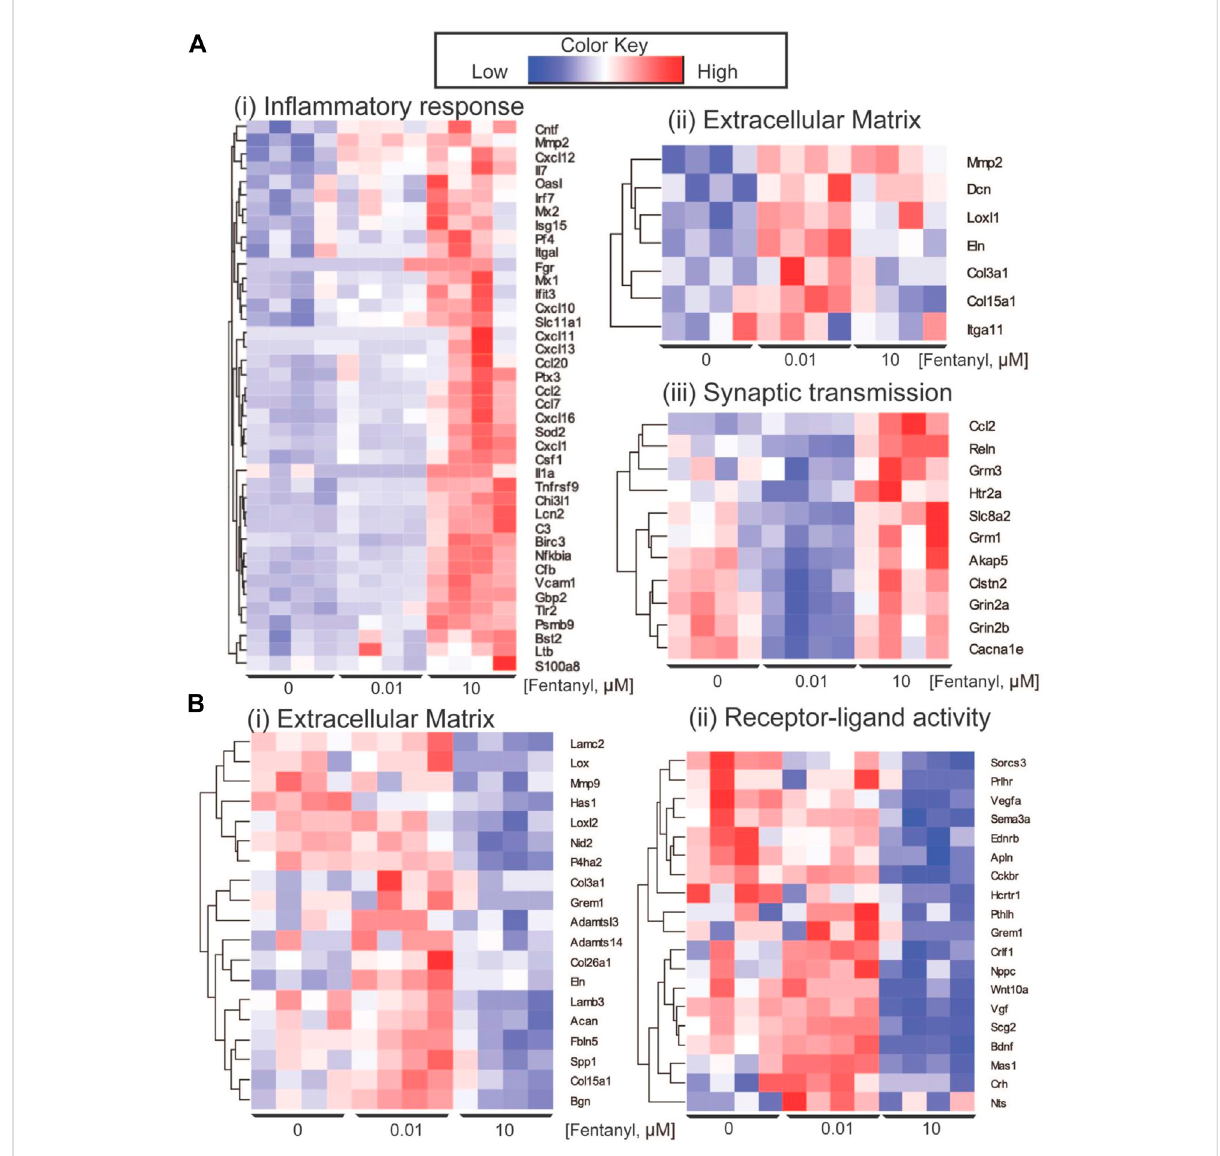
FIGURE 5 Keydifferentiallyexpressedgenes. (A) Heatmapofgenesshowingtheupregulationofgenesincomplexcultureconditionsexposedto10 μ Mof fentanyl for GO biological processes involved in in fl ammation response (i) and synaptic transmission (iii), and speci fi c to 0.01 μ M of fentanyl for processes involved with the extracellular matrix. (B) Downregulation of genes in complex cultures exposed to 10 μ M of fentanyl for processes involved in the extracellular matrix (i) and receptor-ligand activity